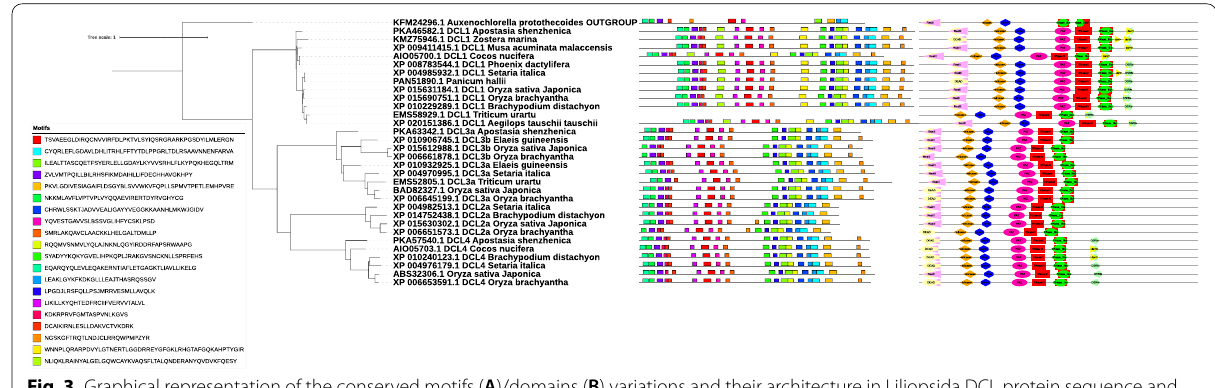
Fig. 3 Graphical representation of the conserved motifs ( A )/domains ( B ) variations and their architecture in Liliopsida DCL protein sequence and their evolutionary relationship within each DCL protein clade. The protein motifs were obtained using MEME suit (http:// memes uite. org/ [1]) and the functional domains were predicted by querying the protein sequence in the Hmmscan search tool (https:// www. ebi. ac. uk/ Tools/ hmmer/ search/ hmmsc an [11]) against the Pfam database (http:// pfam. xfam. org/). Different motifs are represented by different colored boxes and the consensus sequences of the motifs are listed. The domains are marked with different shapes and